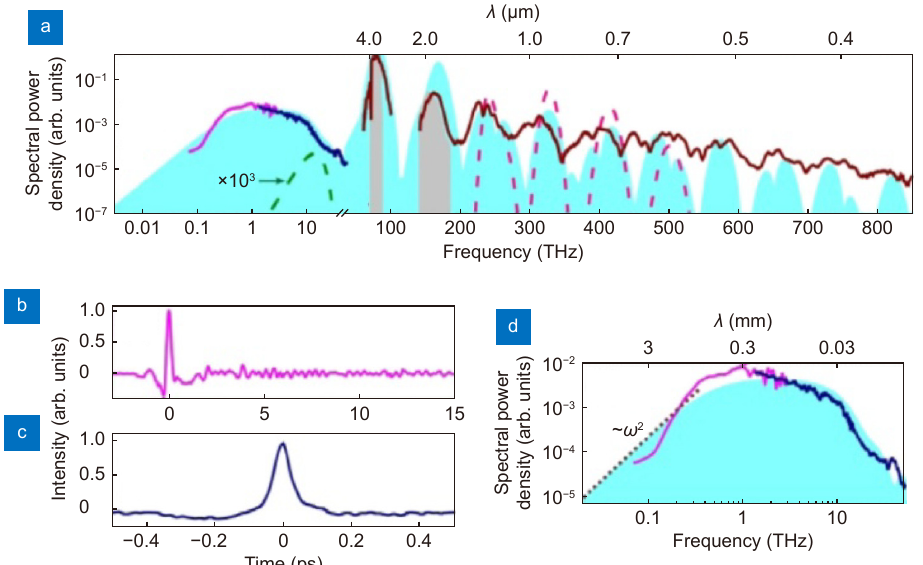
Fig. 11 | ( a ) Spectrum of the millimeter-wave-to-ultraviolet supercontinuum. ( b ) Electro-optic sampling and ( c ) autocorrelation traces of the wave- forms of the THz-millimeter-wave field. ( d ) The millimeter-wave-to-THz part of the supercontinuum spectrum. Figure reproduced with permission from ref. 261 , The Optical